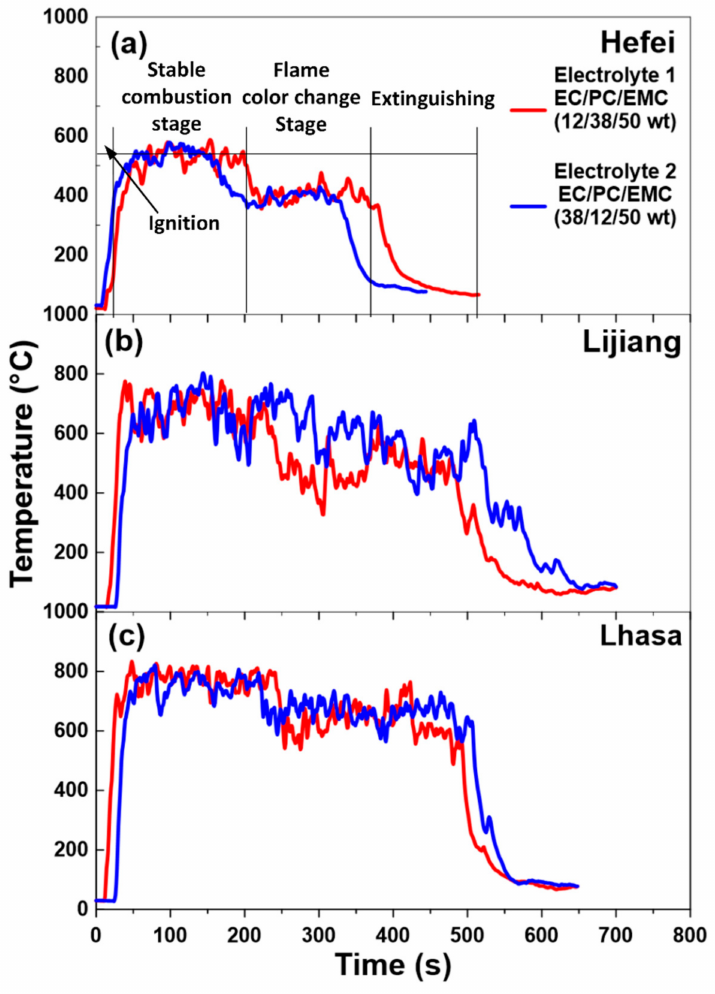
Figure 6. The temperature curves of flame centerline (T1) of two electrolytes in ( a ) Hefei (100.09 kPa), ( b ) Lijiang (76.11 kPa) and ( c ) Lhasa (65.23